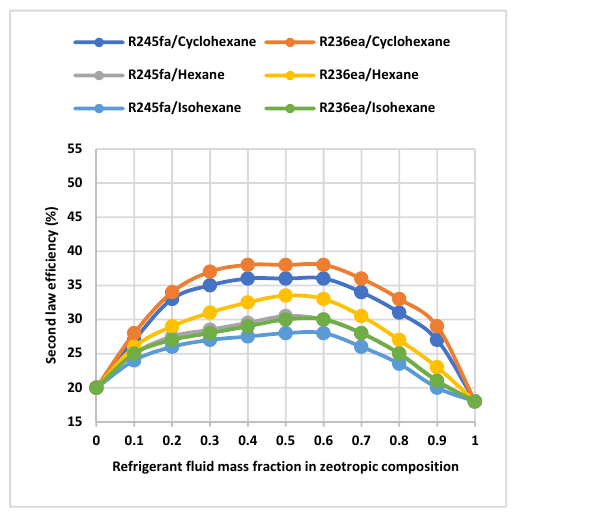
Figure 3. The efficiency of the first law of the whole system and the ORC to the mass fraction of refrigerants in the zeotropic composition.